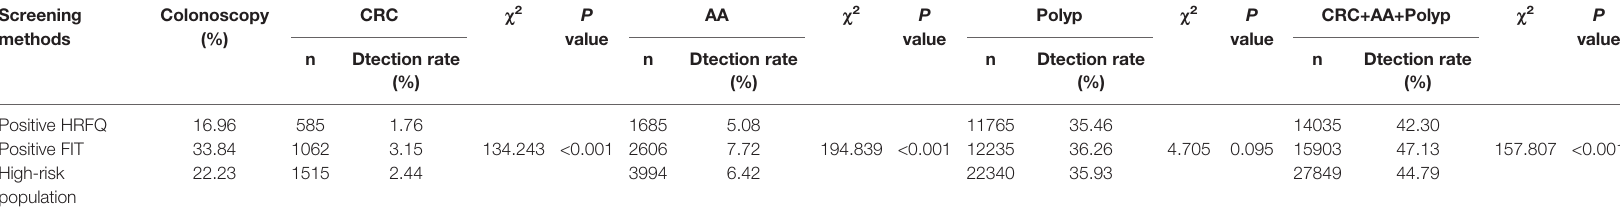
TABLE 9-2 | Comparison of colonoscopy results among different screening methods in Tianjin CRC screening program (2012-2020), (n,%). Screening methods